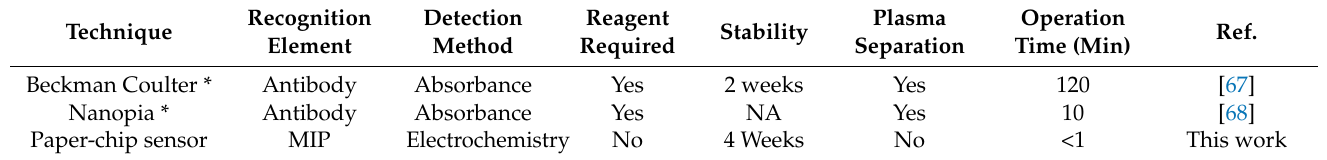
Table 2. Comparison of our disposable sensor with contemporary theophylline monitoring